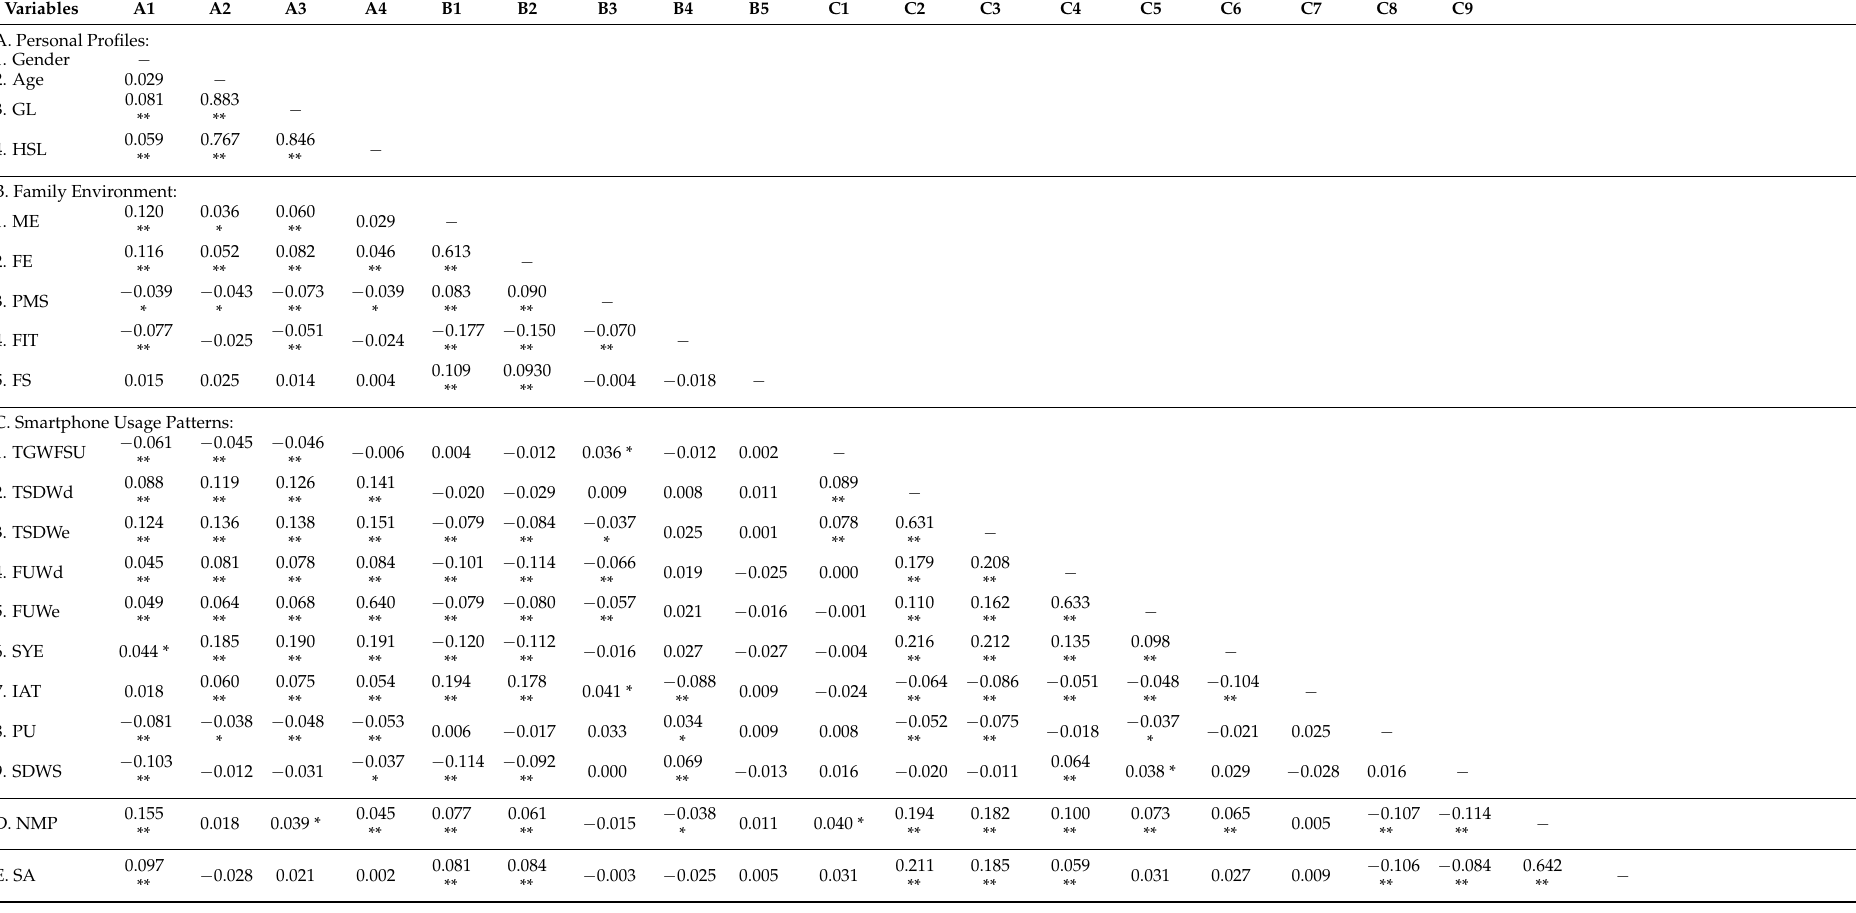
Table 2. Summary of socio-demographic variables, nomophobia, smartphone addiction, and perceived academic performance (Pearson correlation analysis). Personal Profiles Family